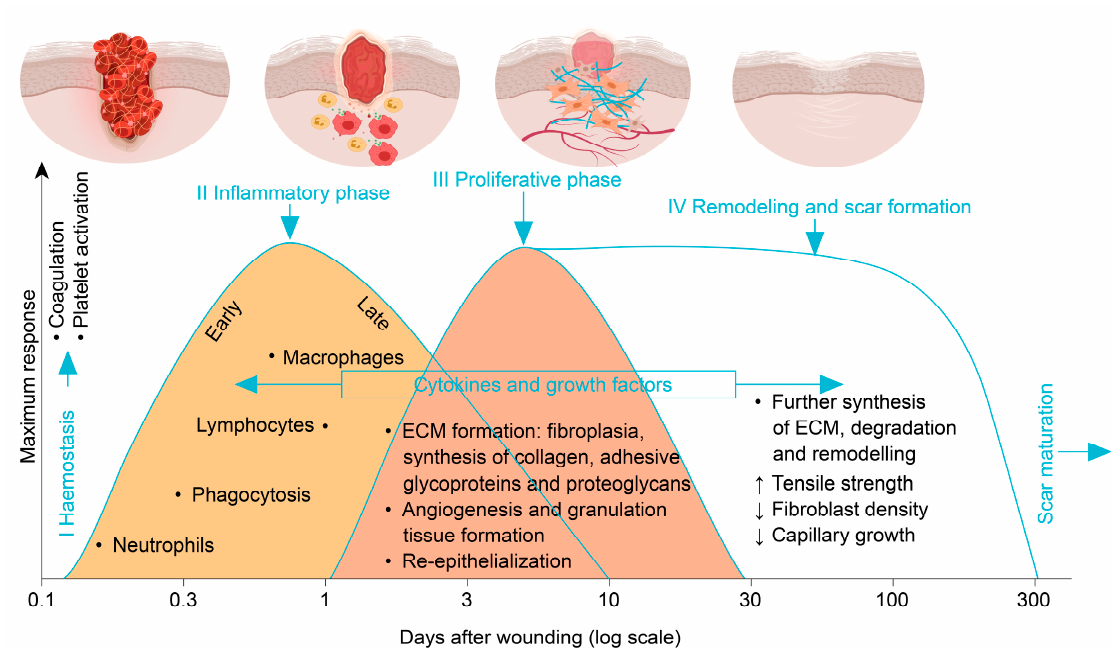
Figure 1. Injury and phases of wound healing. Wound healing timeline with important processes and actors (adapted from Enoch and Leaper [14] with permission from Elsevier).